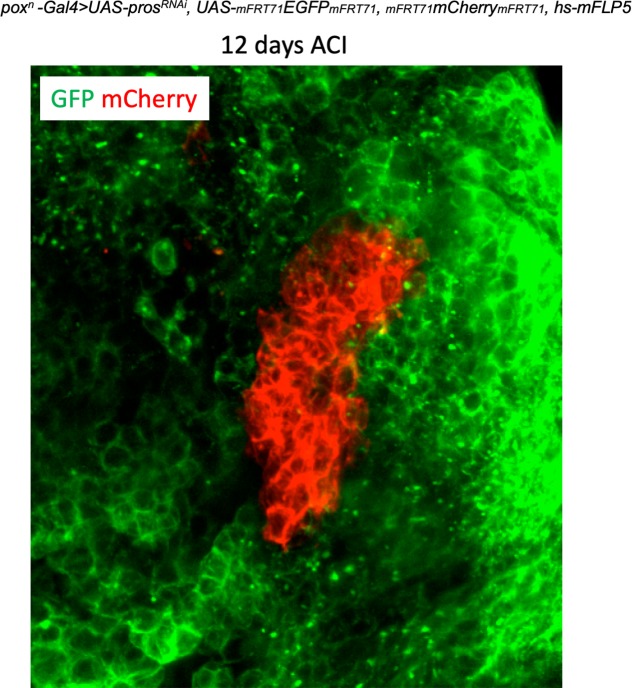
tNBs within a clone do not disperse.The picture depicts a large mCherry+ clones within an adult poxn > prosRNAi tumor 12 days after clonal induction. Clones were induced using the Flybow technique in tumors from 2 day-old adults. mCherry+ clone cells do not disperse allowing the tracking and examination of individual clones over long periods of time.